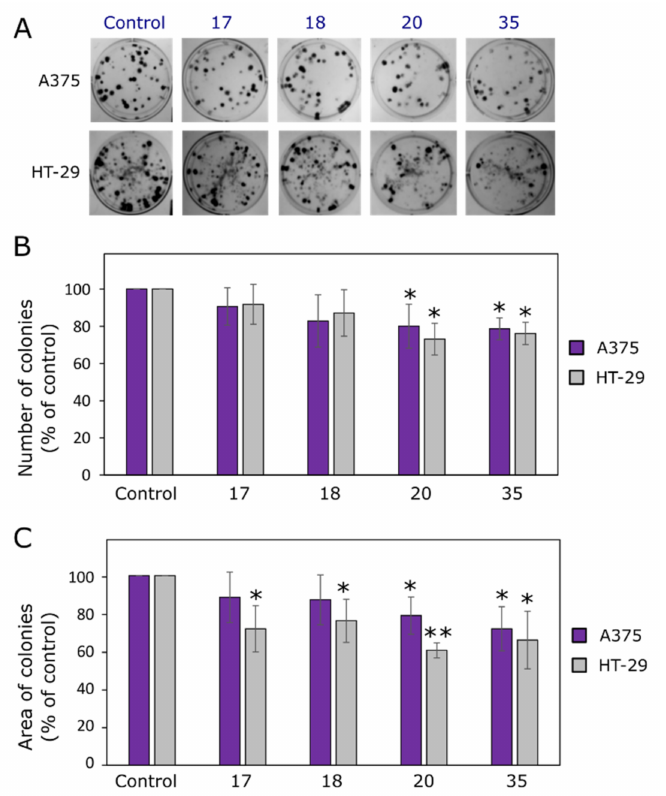
Figure 3. Effects of compounds 17 , 18 , 20 and 35 on colony formation. ( A ) Photos of A375 and HT-29 colonies at the end of the experiment. ( B ) Numbers of colonies at the end of the experiment. ( C ) Areas of colonies at the end of the experiment. Single asterisks (*) indicate p < 0.05 and pairs (**) indicate p < 0.01 compared to the control (untreated cell